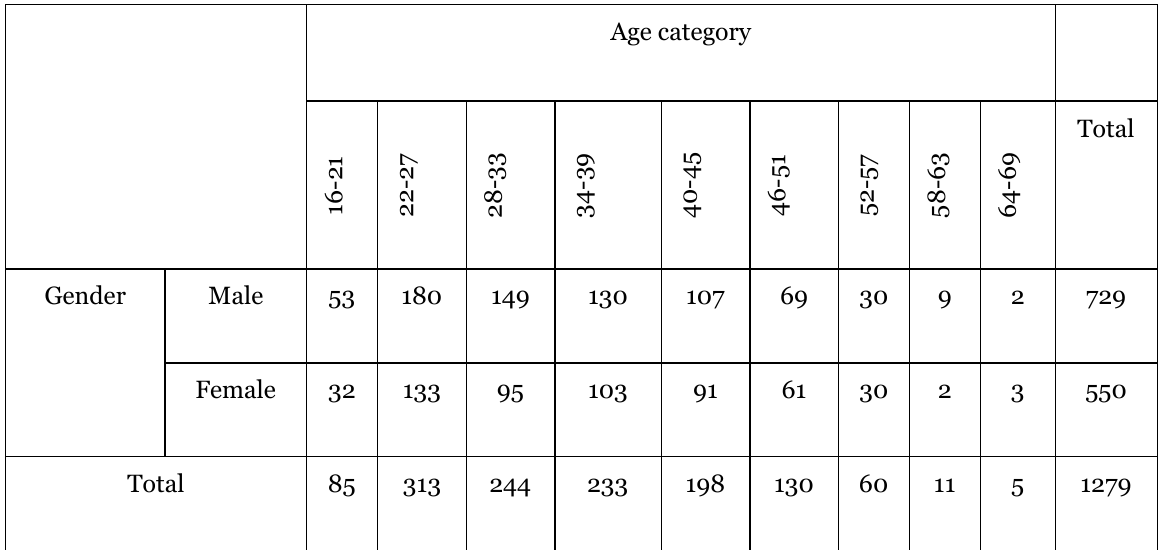
Demographics of the